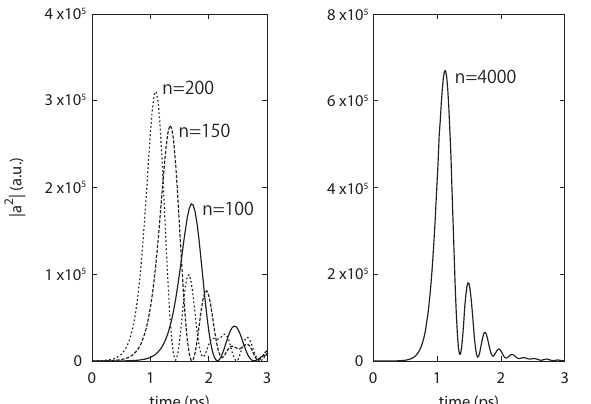
Figure 4. Evolution of an FEL pulse calculated with the JAERI-FEL parameters at δ L = 0 lasing: (Left) 100th to 200th round trips; and (Right) 4000th round trip [13].